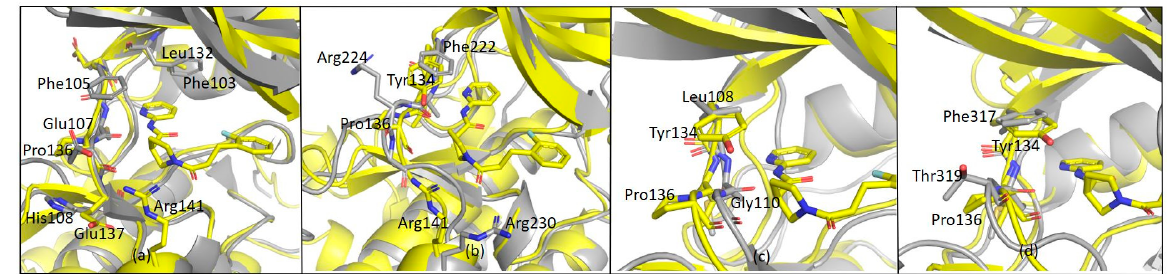
Figure 12. ( a ) Overlapped structure of CDK9 (PDB 3BLQ) and GSK3 β -G12 complex; ( b ) Overlapped structure of GSK3 β -G12 and MLK1 (PDB 4UY9); ( c ) Overlapped structure of GSK3 β -G12 and SAPK2A (PDB 4EWQ); ( d ) Overlapped structure of GSK3 β -G12 and ABL (PDB 4WA9). Other considerations were made comparing MLK1 (i.e., MAP3K9) and GSK-3 β